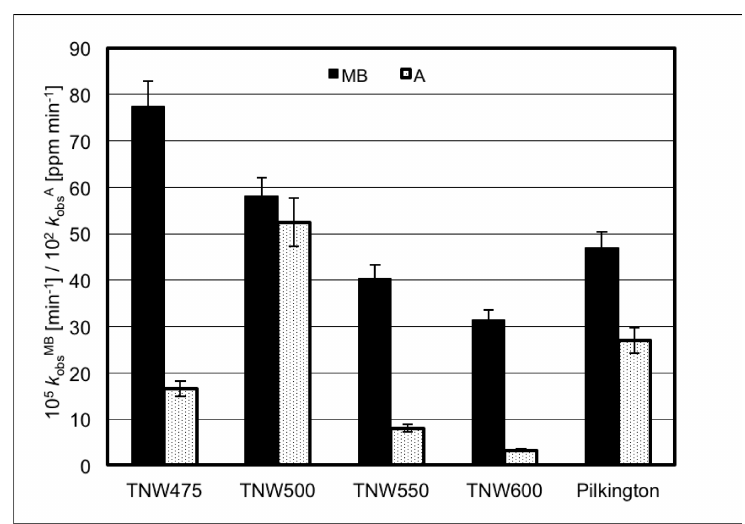
Figure 12. The observable rate constants for methylene blue and acetone degradation under UV light irradiation in the presence of titania nanowires.